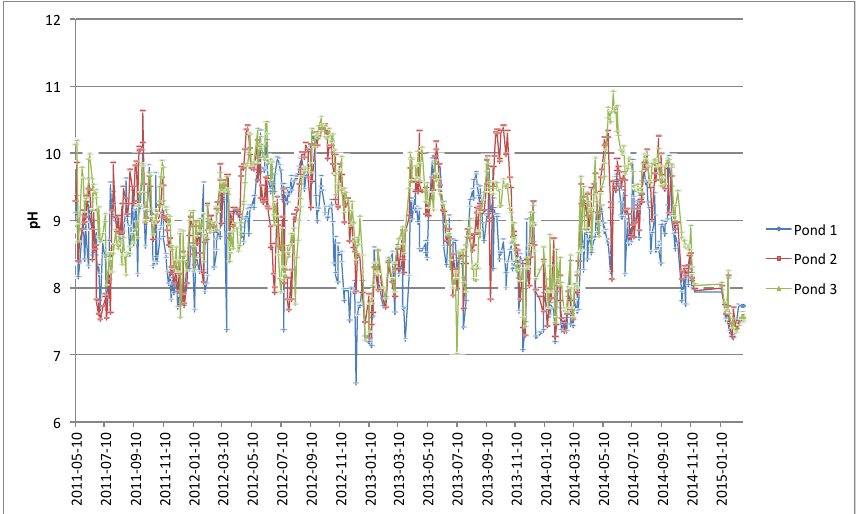
Figure 4. pH fluctuation in the effluents of Pond 1, Pond 2 and Pond 3.